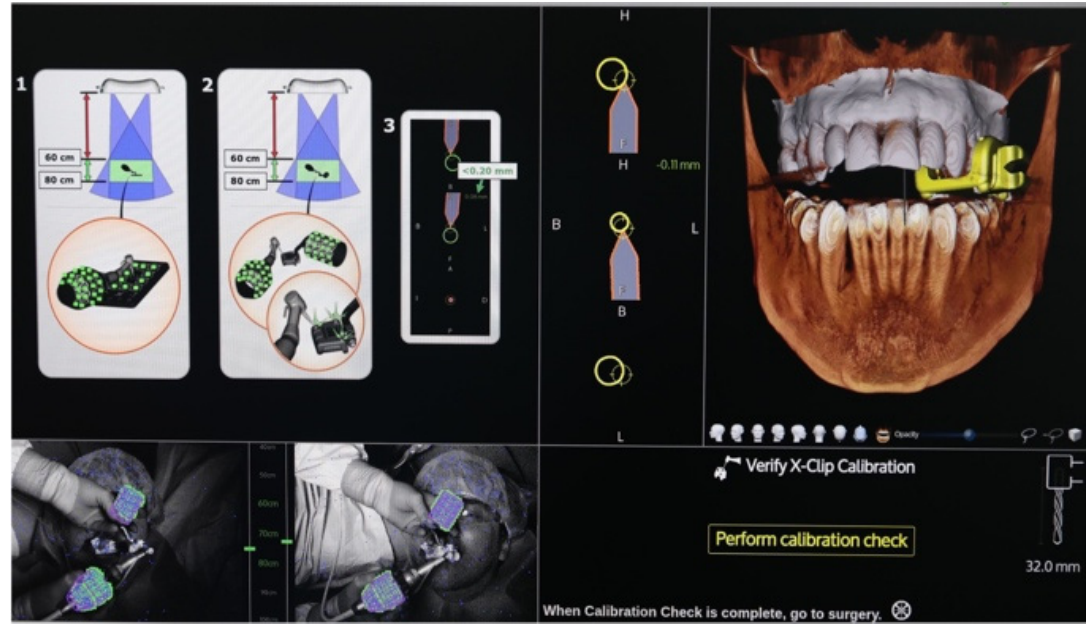
Figure 2. Calibration. Figure 2.